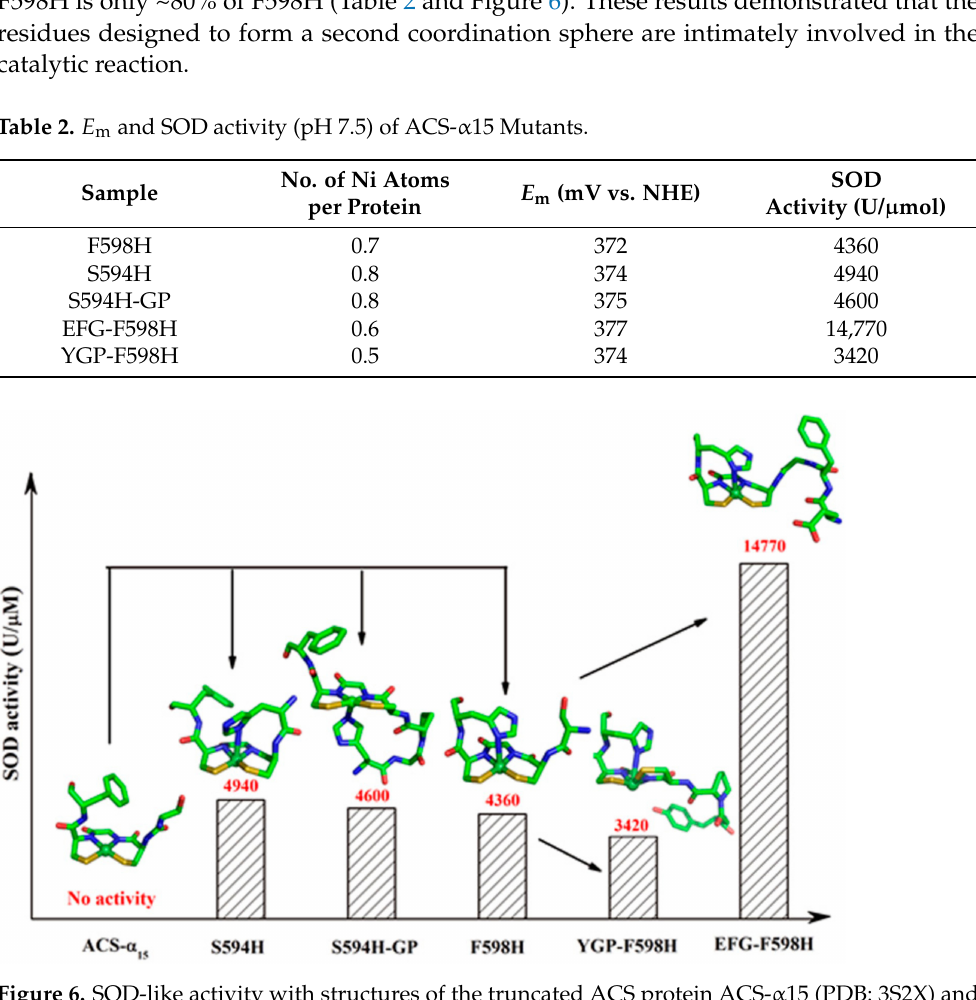
Figure 6. SOD-like activity with structures of the truncated ACS protein ACS- α 15 (PDB: 3S2X) and modeling structures of S594H, S594H-GP, F598H, YGP-F598H and